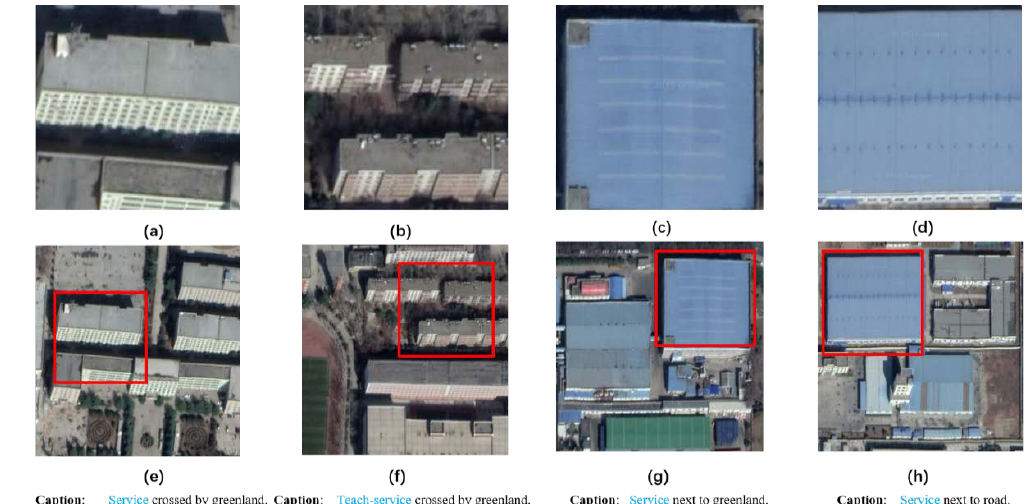
Figure 2. A pair of “fake conflict” samples and a pair of normal samples. ( a–d ) are four small-scale samples; ( e – h ) are corresponding large-scale samples of ( a – d ); ( a , b ) are a pair of ‘fake conflict’ samples; ( c , d ) are a pair of normal samples. We demonstrate small scale samples in large scale samples by drawing red boxes.